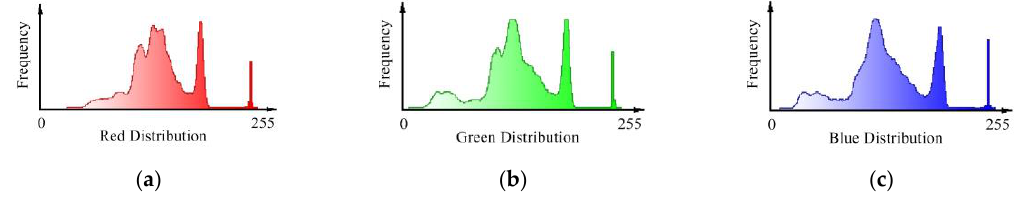
Figure 3. Color distributions of the gesture image. ( a ) Red distribution; ( b ) green distribution; ( c ) blue distribution.